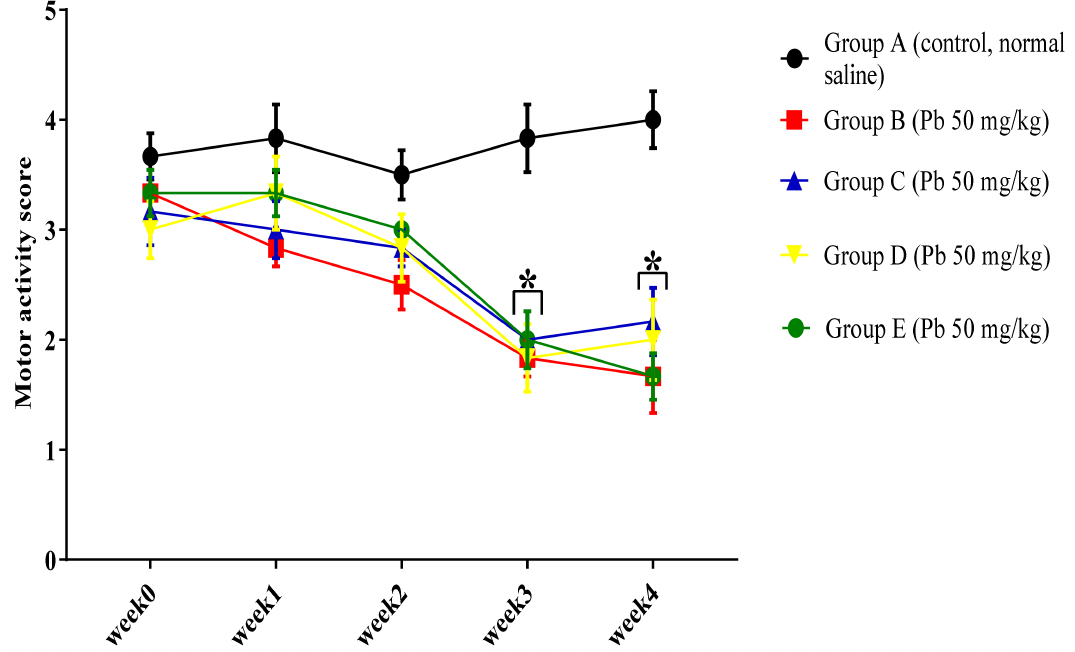
Figure 3. E ff ect of oral administration of Pb acetate on motor score of rats during induction of Pb toxicity. Values are presented as mean ± SEM ( n = 6); * p < 0.05 vs.